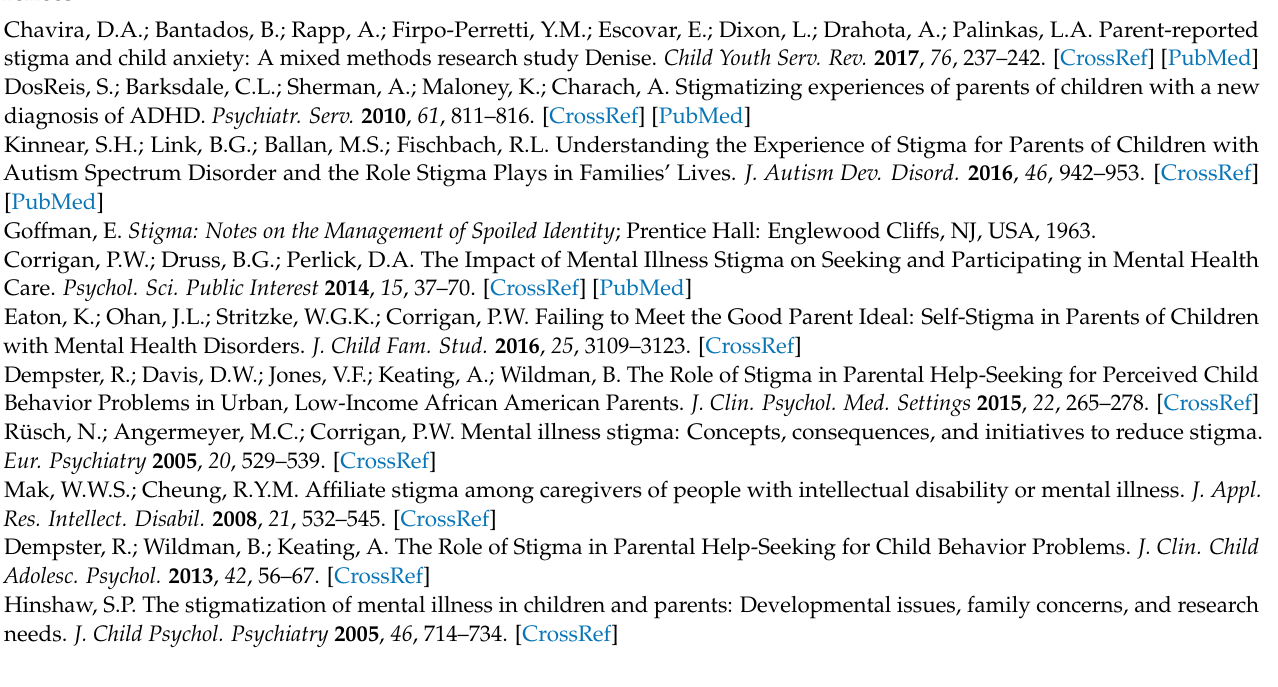
Supplementary Table S3. Irrelevant predictors of parents’ perceived public stigma and affiliate